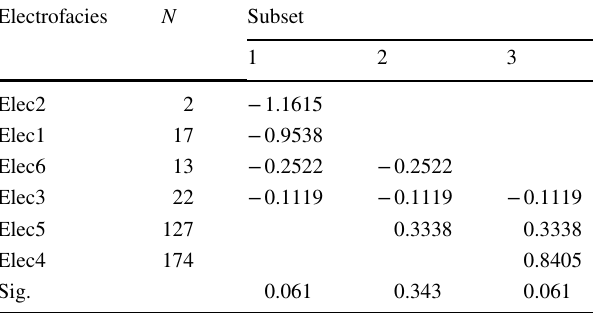
Table 3 Comparison result of electrofacies in permeability with SNK